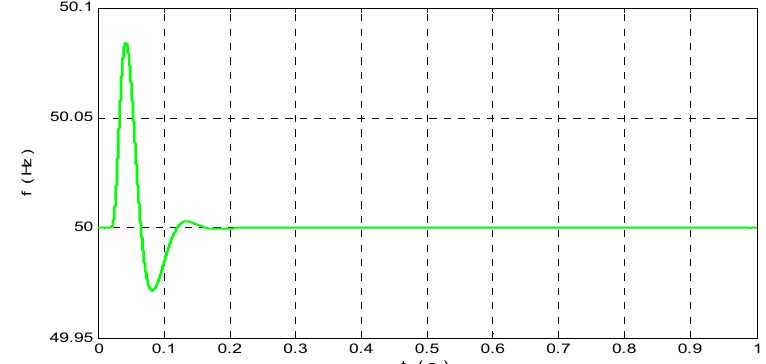
Figure 14. Voltage and current signals (phase c).